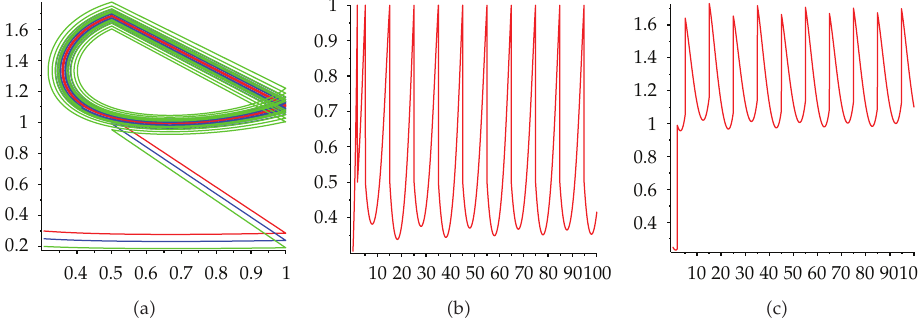
Figure 12: The time series and phase diagram for system (cid:4) 1.4 (cid:5) starting from initial value (cid:4) 0 . 3 , 0 . 2 (cid:5) (cid:4) blue (cid:5) , (cid:4) 0 . 3 , 0 . 1 (cid:5) (cid:4) green (cid:5) , (cid:4) 0 . 3 , 0 . 15 (cid:5) (cid:4) red (cid:5) , α (cid:8) 0 . 5 , β (cid:8) 0 . 2 , q (cid:8) 0 . 8 , h (cid:8) 1 , x